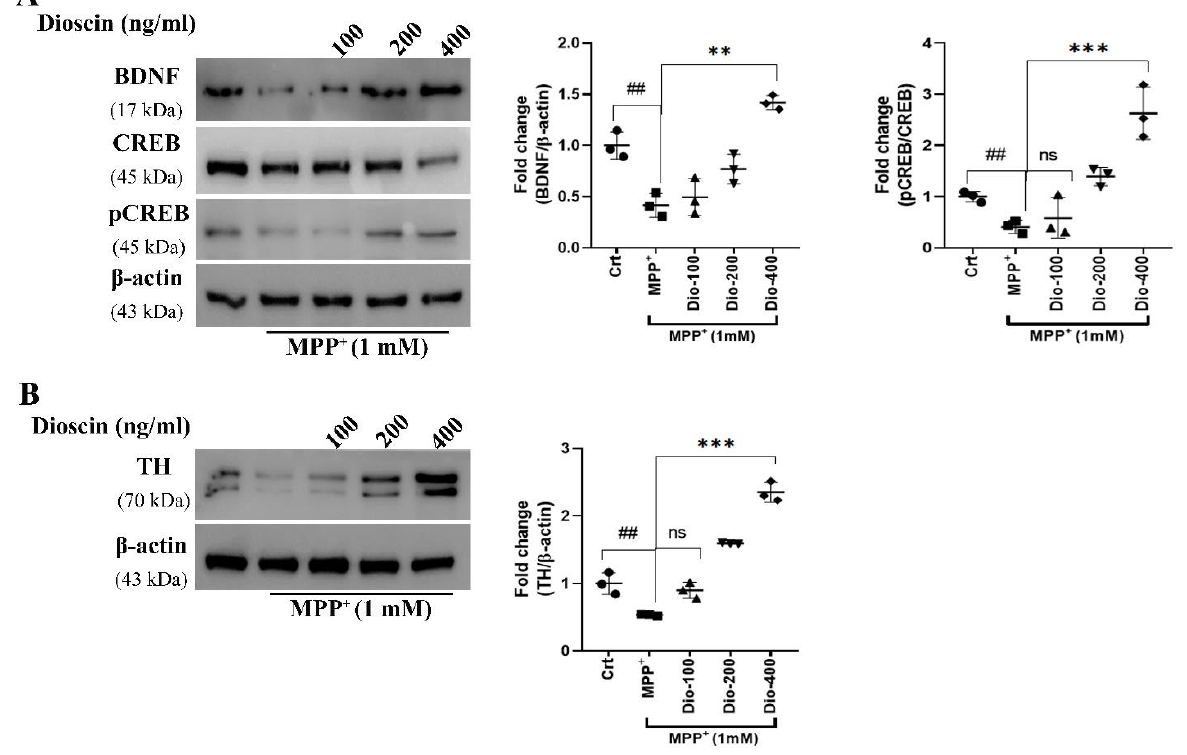
Figure 4. Dioscin improves neurotrophic factors and TH cells . Representative data of TH (first row in the blot image) ( B ), BDNF, CREB and pCREB ( A ) immunoblots of whole-cell (SH-SY5Y) lysates. Cells were pre-treated with different doses of dioscin followed by treatment with MPP + (1 mM) for 24 hr ( A ); optical density was measured using ImageJ software. Each WB is representative of 3 in- dependent experiments. The bar graphs represent the ratio of respective protein/β-actin or CREB normalised against control (non-treated) samples or MPP + or MPP + +treated cells and are mean ± SEM of 3 independent experiments (n = 3). ns = not significant; # p < 0.05, ## p < 0.01 and ### p < 0.001, in comparison to non-treated group; * p < 0.05, ** p < 0.01 and *** p < 0.001, compared to toxin and treatment group.